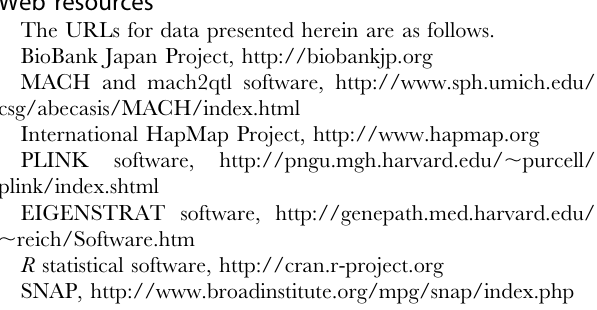
Table S1 Characteristics and distributions of traits in the Japanese subjects. Table S2 Correlation among the WBC subtypes and the proportions explained by the SNPs identified in the study. Table S3 Results of genome-wide association studies for the WBC subtypes. Table S4 The associations in the previously-reported WBC subtype-associated loci. Table S5 Characteristics and distributions of traits in the study populations by the CHARGE Consortium. Table S6 Characteristics and distributions of the traits enrolled in the pleiotropic association